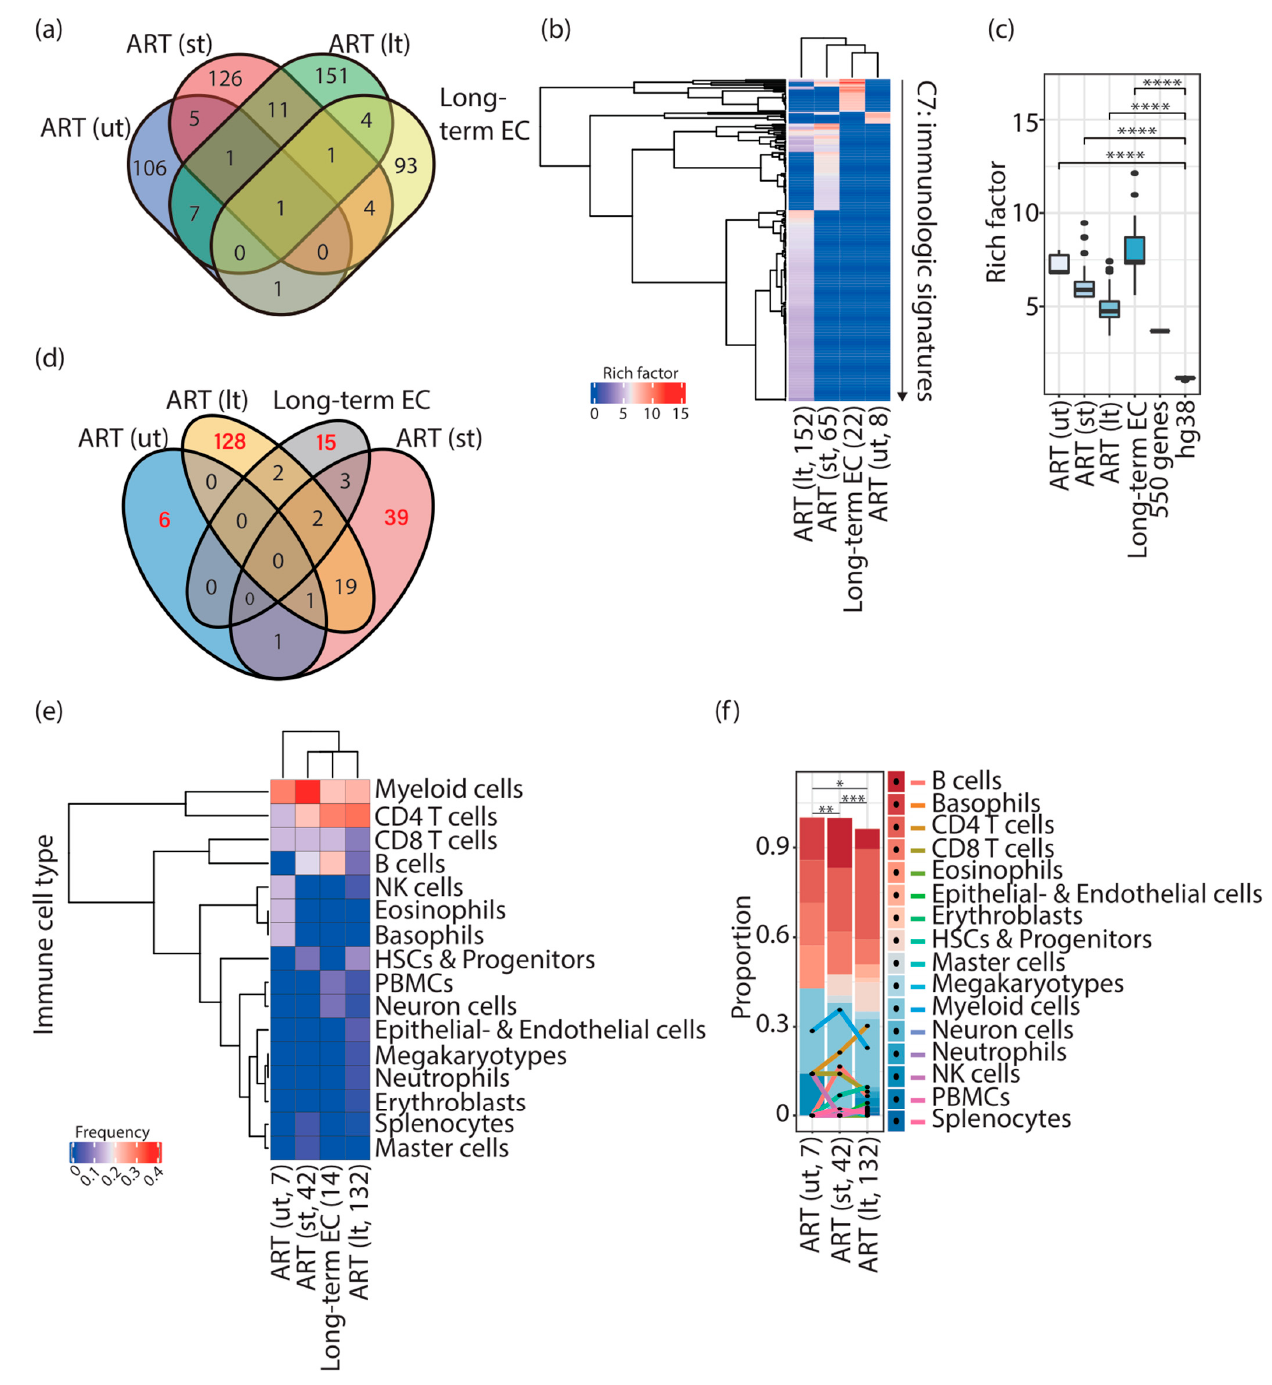
Figure 1. Distinct immunologic signatures were enriched in HIV-1-infected individuals and elite controllers. ( a ) Venn diagram representing the overlap of input genes in HIV-1-infected individuals and elite controllers. Genes shared among different groups of input genes are listed in Table S27. ( b ) Cluster heatmap representing immunologic signatures enriched in HIV-1-infected individuals and elite controllers. Parentheses placed under the column indicate the status of ART (“lt” refers to HIV-1-infected individuals subjected to a long period of ART; “st” refers to HIV-1-infected individuals subjected to a short period of ART; “ut” refers to pretreatment HIV-1-infected individuals) followed by the quantity of enriched immunologic signatures. The color scale represents the magnitude of the enrichment represented by rich factors. ( c ) Box plots representing the enrichment of immunologic signatures represented by rich factors. Commands executed to calculate rich factors